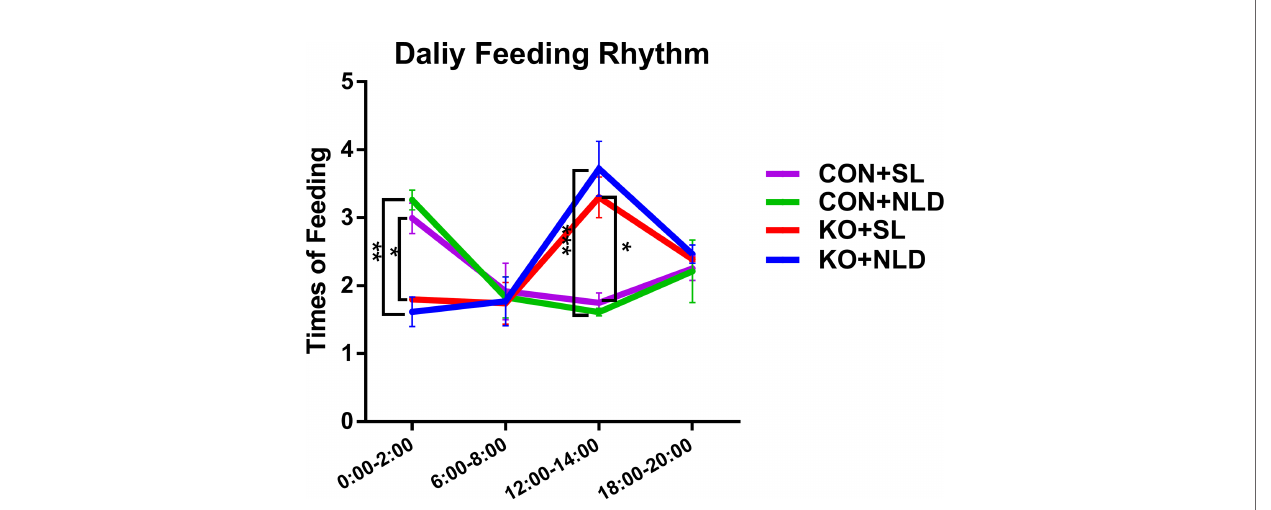
FIGURE 1 | Daily feeding rhythm of KO and CON mice under NLD and SL. KO, Per2 gene knockout ( Period2 − / − ) mice; CON, wild-type ( Period2 +/+ ) mice; NLD, normal light – dark cycle treatment of 12 h of light and 12 h of darkness; SL, short-light treatment of 8 h of light and 16 h of darkness. Recorded the times of feeding of each mouse from 0:00 – 2:00, 6:00 – 8:00,12:00:14:00, and 18:00 – 20:00 during the trial period using surveillance cameras. Statistical analyses were conducted using two-way ANOVA. * p < 0.05, signi fi cant difference; ** or *** p < 0.01 or p < 0.001, extremely signi fi cant difference. Results are presented as means ± SEM (n = 4 per group).